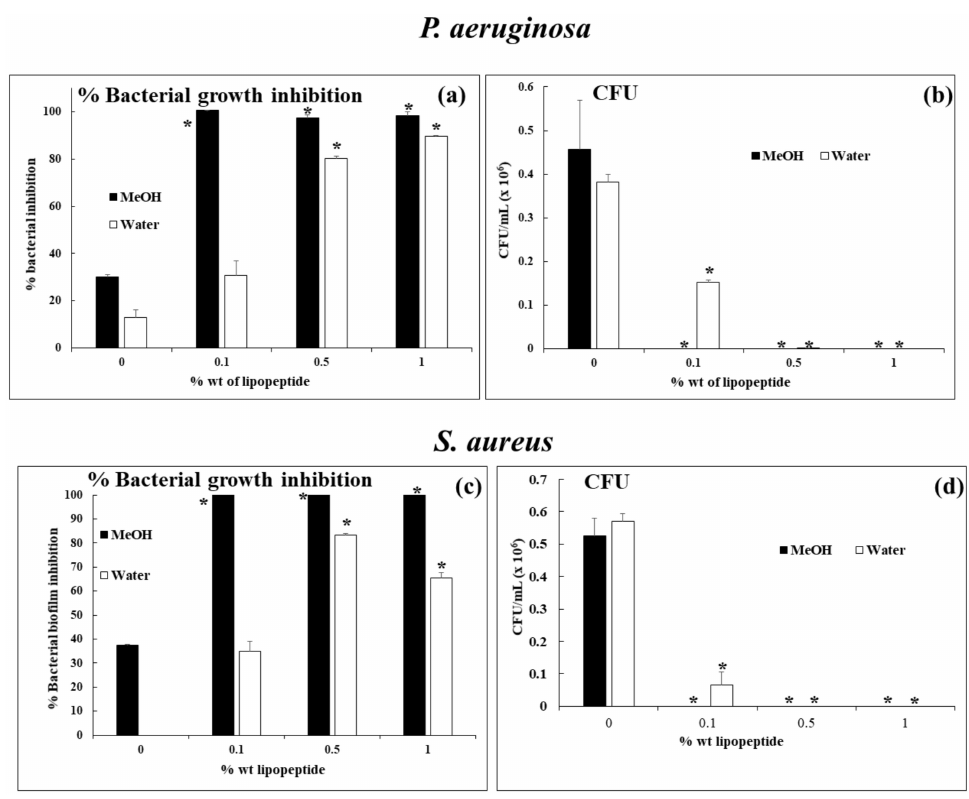
Figure 4. The antibacterial activity of lipopeptide containing gels against P. aeruginosa ( a , b ) and S. aureus ( c , d ). Results presented are averaged from three independent experiments done in triplicate. ( a , c ) represent percentage of bacterial reduction determined by the optical density of the solution. ( b , d ) are the recovered bacterial cells from the gel samples after sonication. * Indicates p <